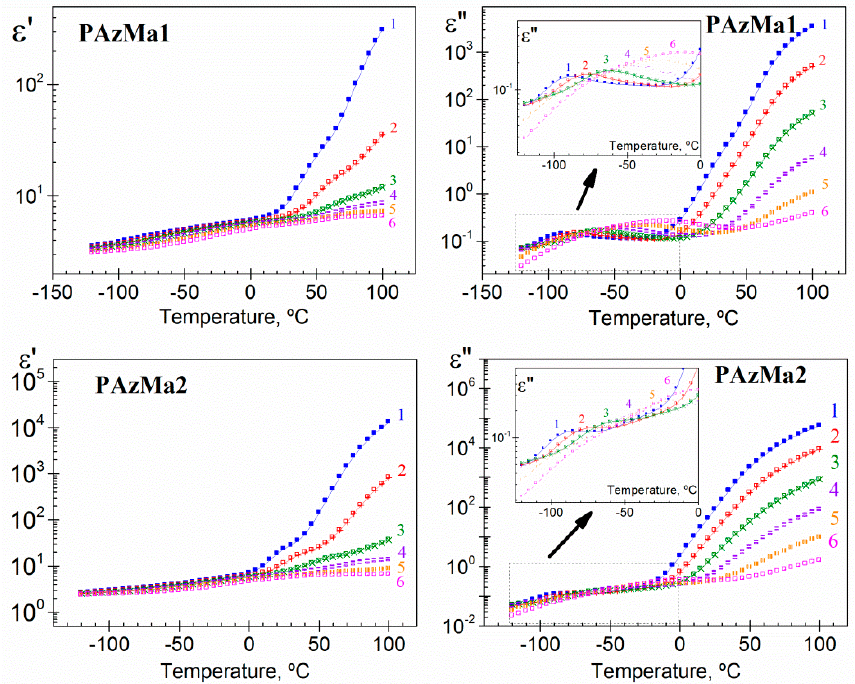
Figure 6. Real and loss components of the complex dielectric permittivity as a function of temperature for PAzMa1 and PAzMa2 at 1.19 × 10 0 [1: square], 8.73 × 10 0 [2: ballot box with +], 9.52 × 10 1 [3: ballot box with × ], 1.04 × 10 3 [4: square with top half black], 1.13 × 10 4 [5: square with right half black] and 1.2 × 10 5 [6: square containing black central point].